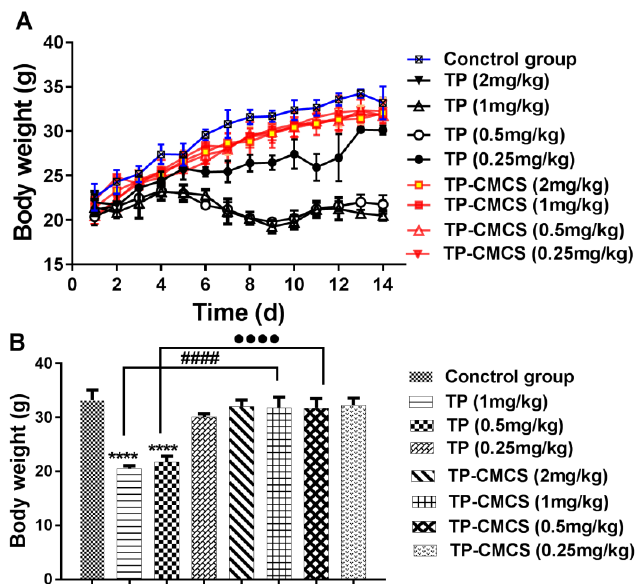
Figure 5. Body weight changes of different drug-treated groups for 14 days ( A ) and on the last day ( B ). Mice were administrated with TP (2, 1, 0.5, and 0.25 mg/kg of TP) or TP-CMCS (2, 1, 0.5, and 0.25 mg TP equivalent/kg). **** Represents p <0.0001, vs control group; #### represents p <0.0001, TP-CMCS (1 mg/kg) vs TP (1 mg/kg); ●●●● represents p <0.0001, TP-CMCS (0.5 mg/kg) vs TP (0.5 mg/kg).